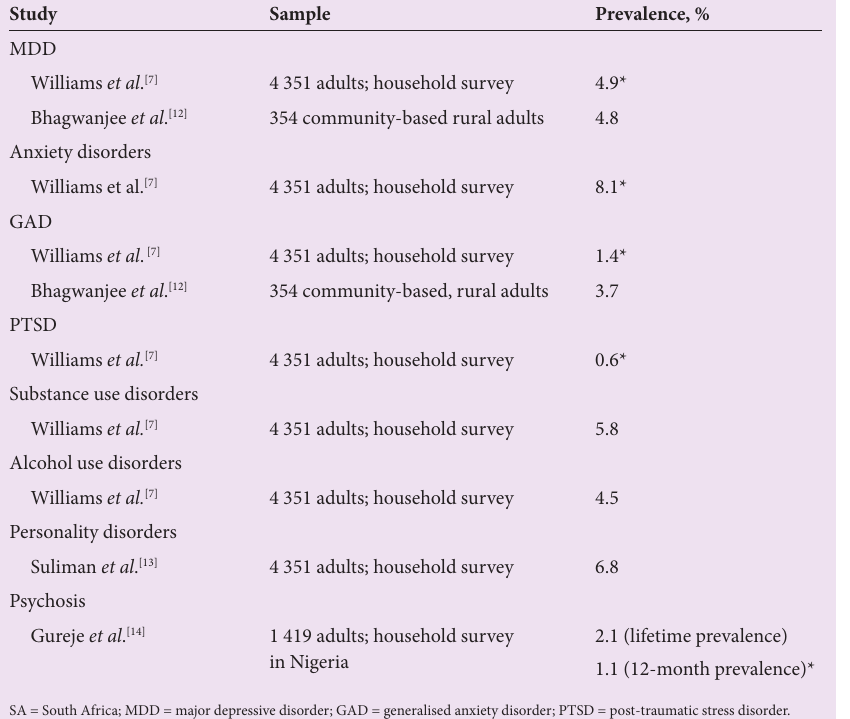
Table 1. Twelve-month prevalence of mental disorders in adults in SA Study